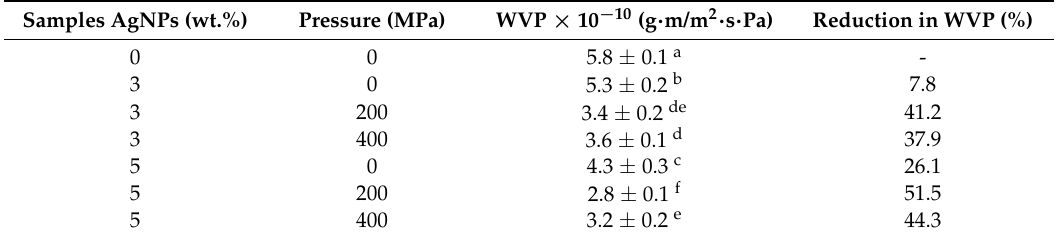
Table 1. Effect of high pressure treatment on the water vapour permeability of PLA/AgNPs nanocomposite